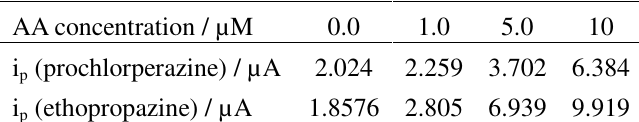
Table 1. Variation of peak current with ascorbic acid (AA) concentration. Concentration of prochlorperazine and ethopropazine: 10 (cid:1) M, other conditions as in Figure